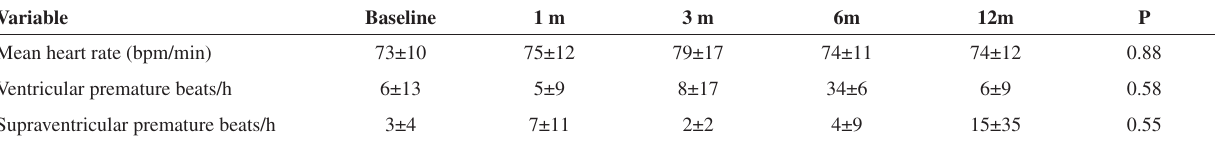
Table 5 - Data from 24-h ECG monitoring (Holter) at baseline and during the first year of follow-up. Variable